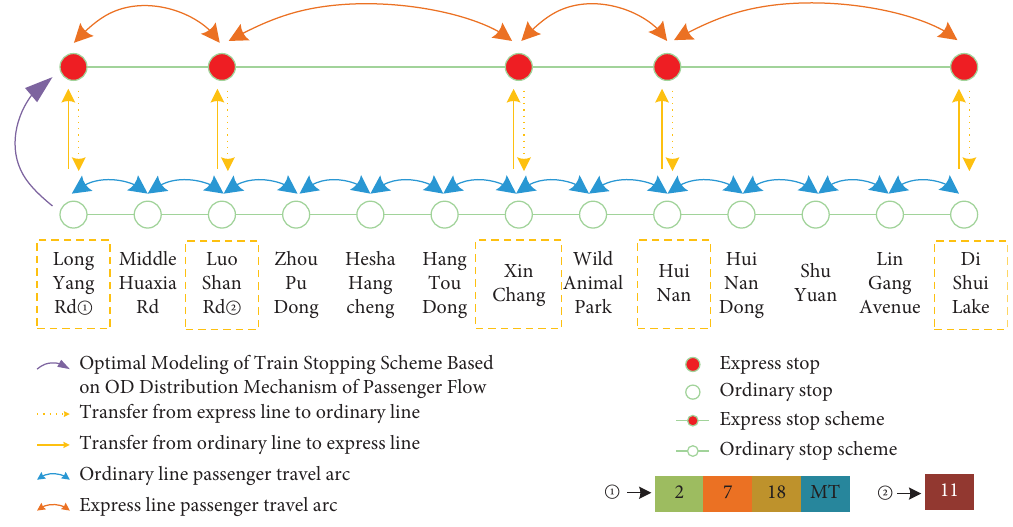
Figure 4: Te optimized stop